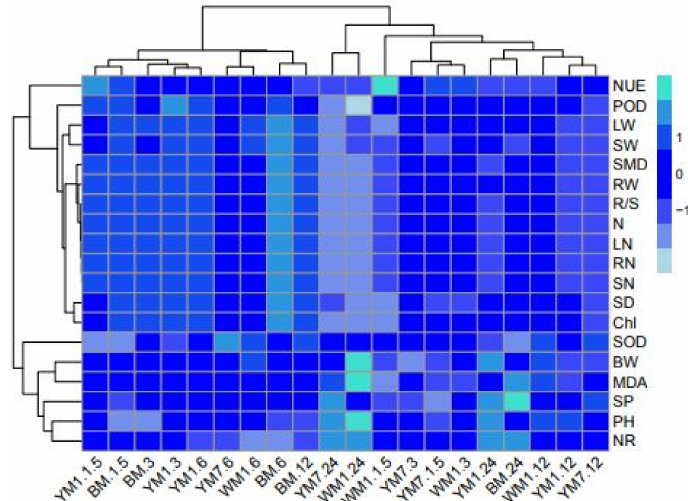
Figure 6. A heatmap showing the relationship of treatments with the studied parameters of growth, antioxidant capacity, and N accumulation in hemp. The colors represent variations in the data. PH, plant height; SD, stem diameter; LW, leaf weight; SW, stem weight; RW, root weight; BW, biomass weight; R/S, root to shoot ratio; SMD, stem mass density; Chl, chlorophyll content; SP, soluble protein; NR, nitrate reductase activity; SOD, superoxide dismutase; POD, peroxidase; MDA, malondialdehyde; RN, root nitrogen; SN, stem nitrogen; LN, leaf nitrogen; N, total nitrogen; NUE, nitrogen use efficiency. YM1.1.5, cultivar YN1 + 1.5 mmol/L N; YM1.3, cultivar YN1 + 3 mmol/L